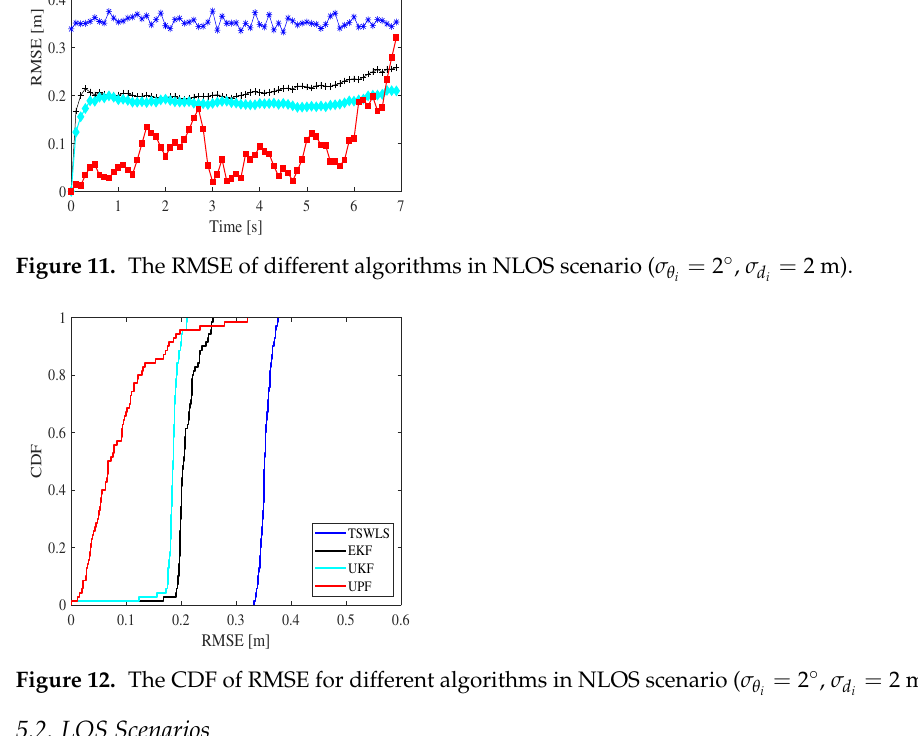
Figure 13. The RMSE of different algorithms in LOS scenario ( σ θ